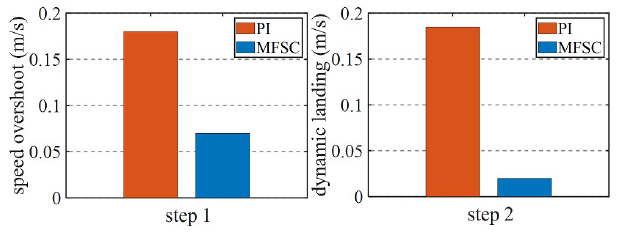
Figure 18. Bar chart of speed variation for two controllers.